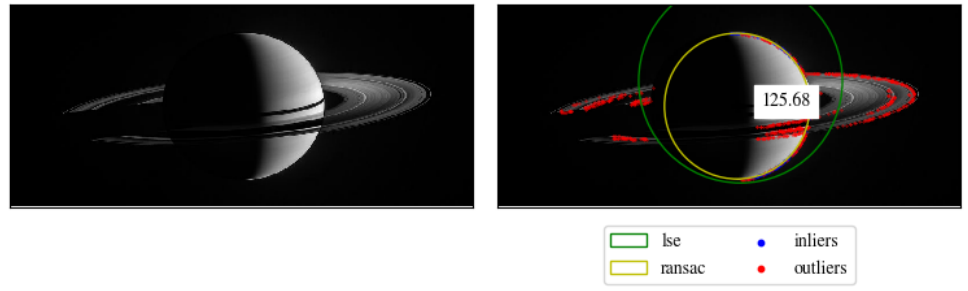
Figure 12. Estimation of Saturn radius comparison between RANSAC and LSE. RANSAC is able to provide accurate results even with a significant amount of outliers given by the rings of Saturn, whereas LSE is unable to provide satisfactory